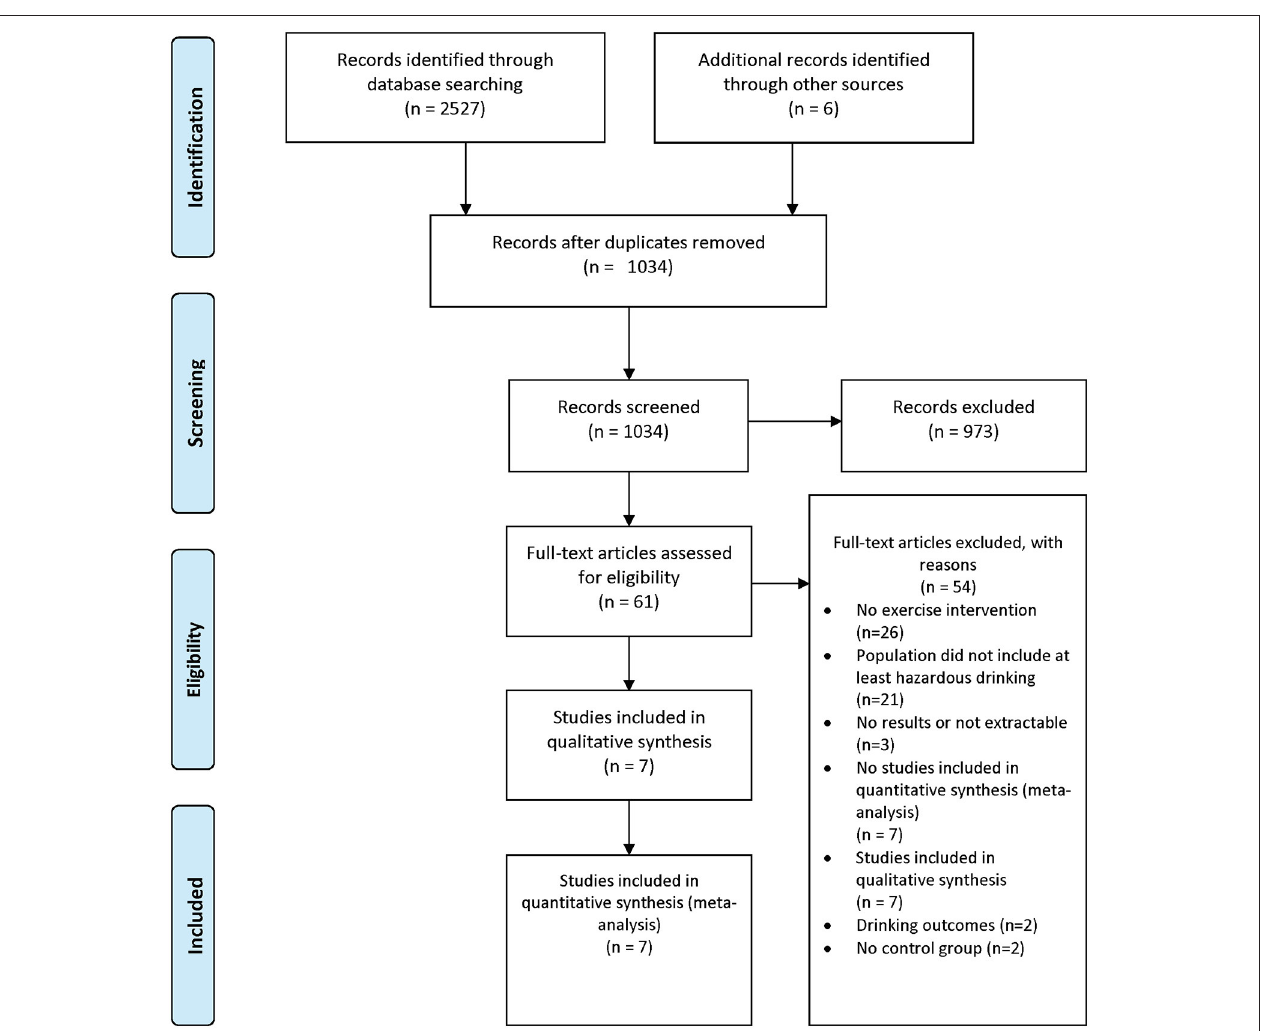
FIGURE 1 | PRISMA flow diagram. PRISMA, preferred reporting items for systematic reviews and meta-analyses. This PRISMA diagram contains public sector information licensed under the Open Government Licence v3.0. (Adapted From: Moher et al.,